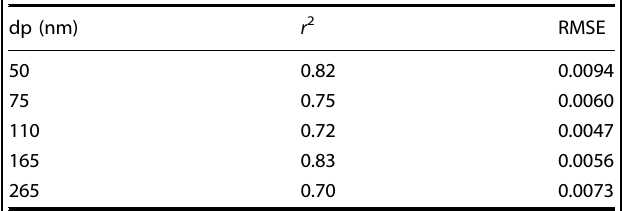
Table 2. Quality of fi t of RF model for test data sets.